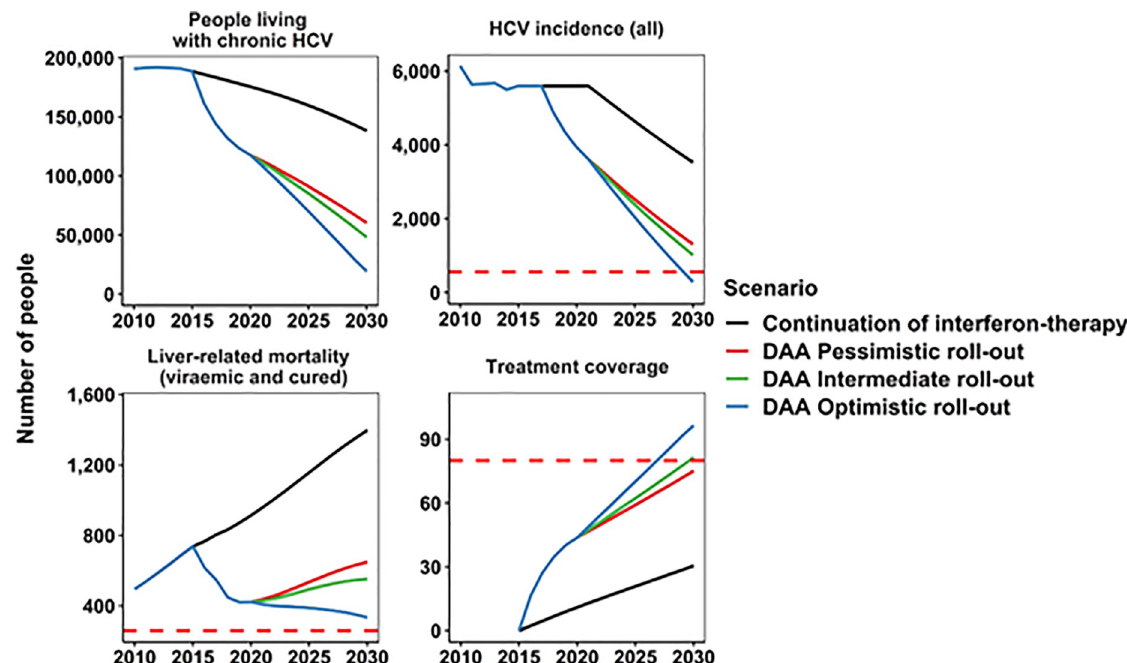
Fig 2. Annual change in people living with chronic HCV, HCV incidence, treatment coverage, and liver-related mortality in Australia 2010–2030 compared to WHO HCV elimination targets (red dotted lines: 90% reduction in incidence, 80% eligible treated, 65% reduction in deaths).